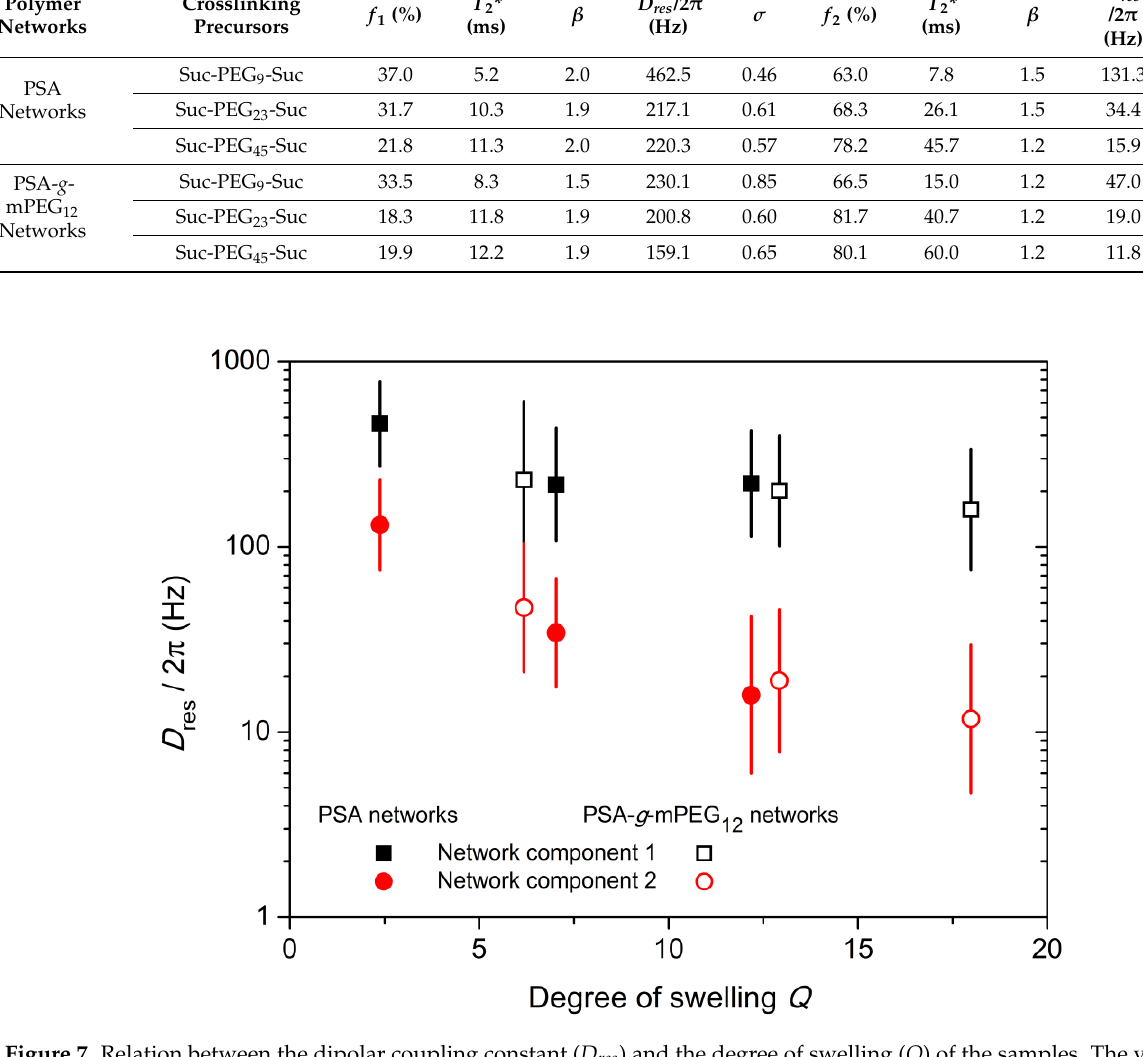
Figure 7. Relation between the dipolar coupling constant ( D res ) and the degree of swelling ( Q ) of the samples. The vertical bars represent the distribution widths of σ from the Table 2.